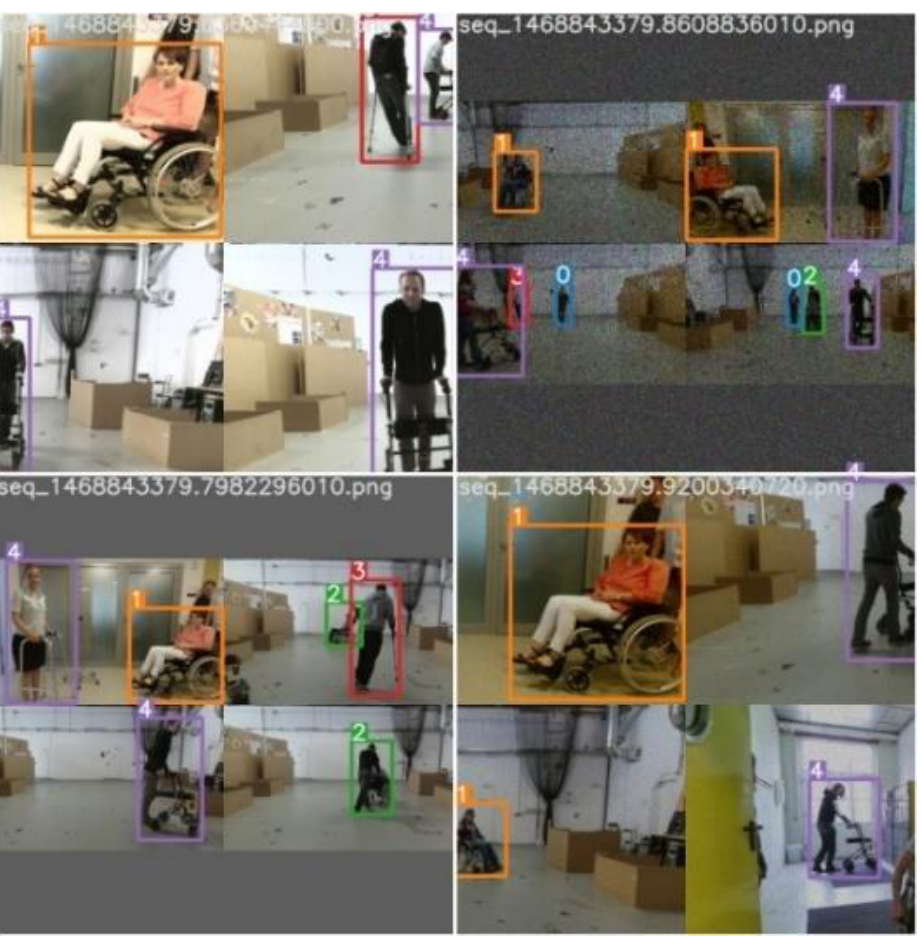
Figure 9. Samples from the training phase of a batch of 4 images from the MobilityAids dataset augmented with Mosaic, HSV alterations, ISO noise, and LR flips and scaling.